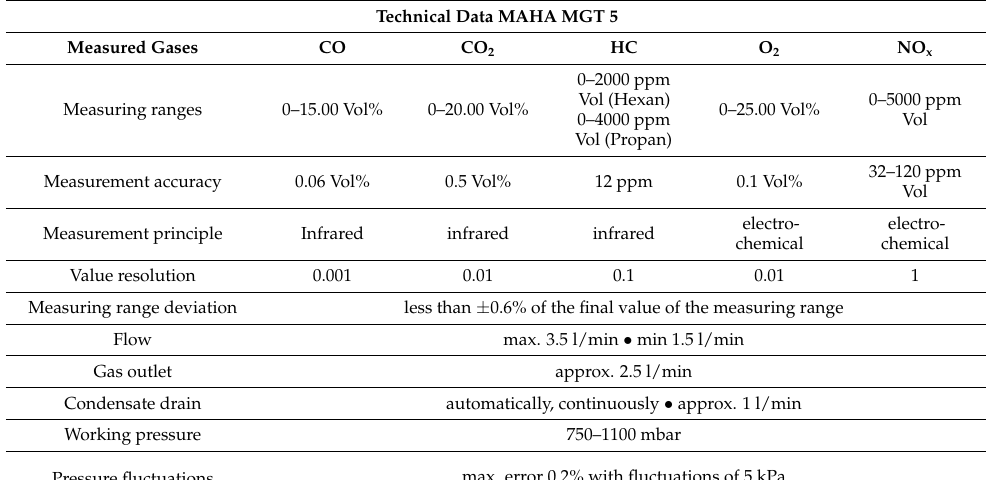
Figure 6. Exhaust gas analyzer MAHA MGT 5 [44]. Table 2. Technical data MAHA MGT5